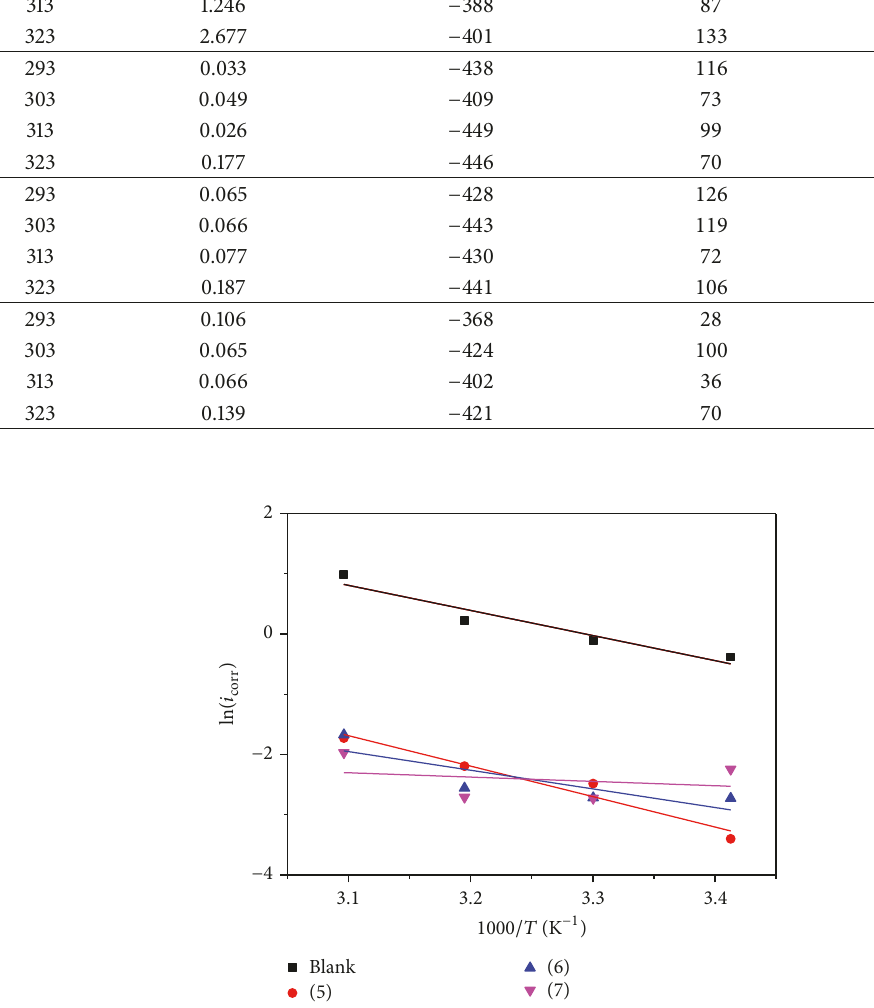
Figure 6: Arrhenius plots of ln (𝑖 corr ) versus 1/𝑇 (K −1 ) in 1MHCl in the absence and presence of 5mM of